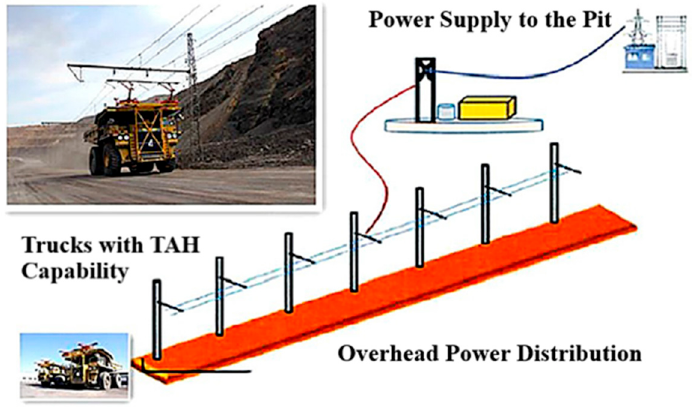
Figure 11. System design of TA.